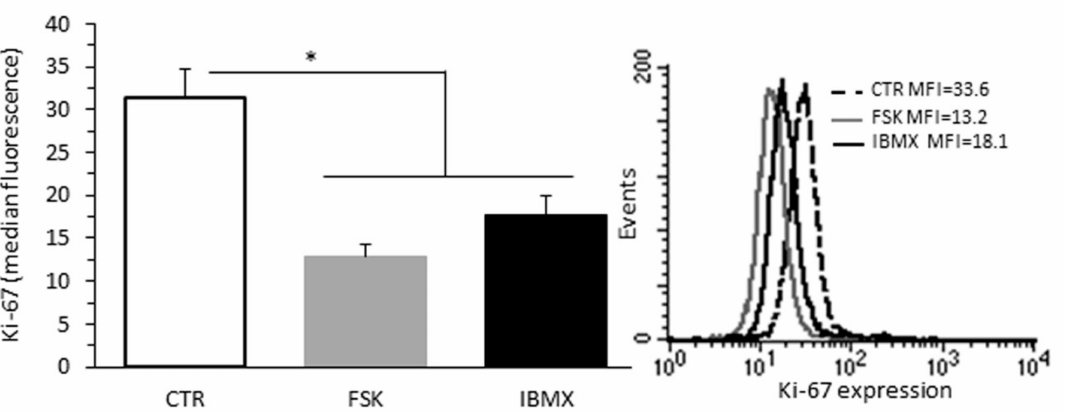
Figure 4. Effect of cAMP levels on B16F10 cell proliferation. ( Left panel) Flow cytometry analysis of cell proliferation after staining with Ki-67 nuclear antigen of B16F10 cells untreated or treated with FSK, a direct adenylyl cyclase activator, or IBMX, a non-selective phosphodiesterase inhibitor. Data from three independent experiments are reported. ( Right panel) On the ordinate y-axis, the median fluorescence intensity values are reported. Results from one representative experiment out of three are shown, * p <